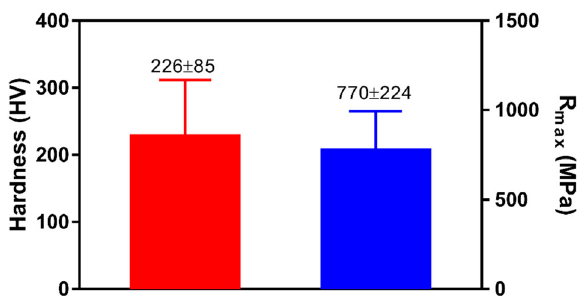
Fig. 4 A SEM micrograph of BMMSCs adhered to the surface of TiNbSn/Mg using an SE detector. ×2000 of magni fi cation. The white arrows indicate the presence of cytoplasmic projections. B SEM micrograph zoom of Fig. 4A indicating possible extracellular vesicle release. ×5000 of magni fi cation